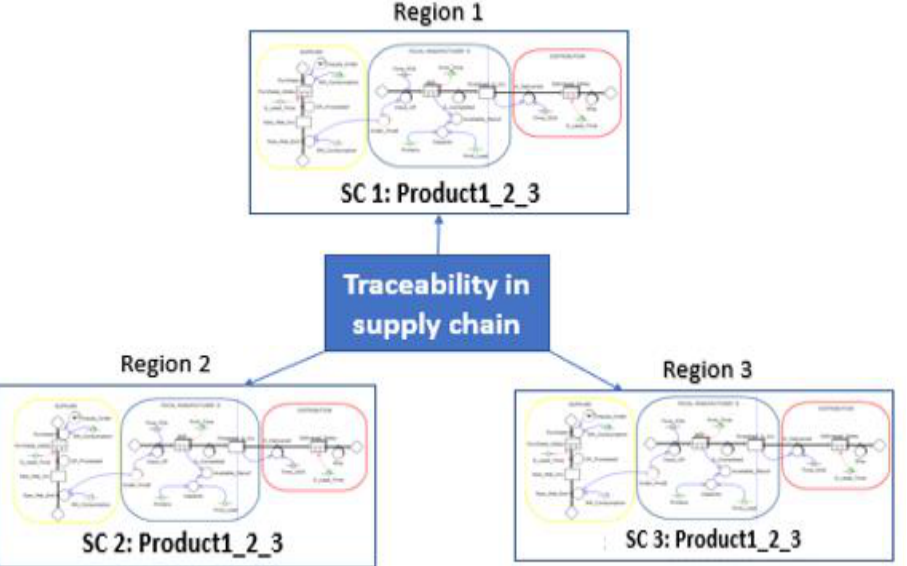
Figure 12. Decentralized additive supply chain. Source: own elaboration. Figure 14. Decentralized additive supply chain. Source: own elaboration.